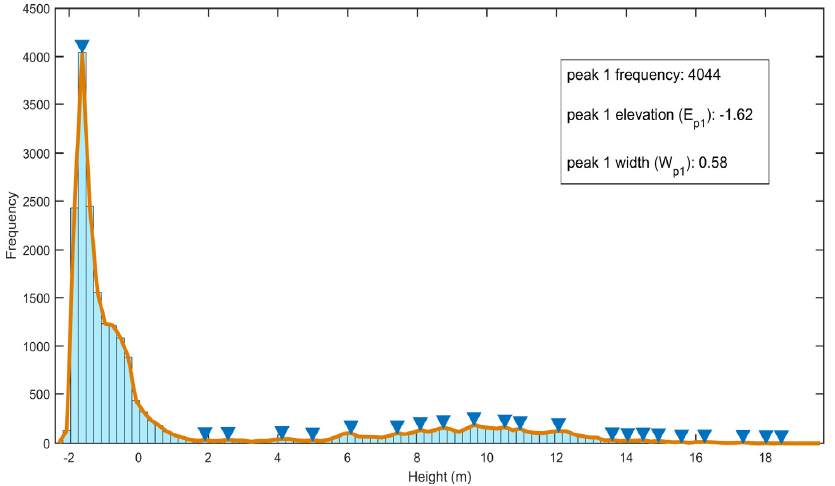
Figure 2. Histogram filtering for DTM region. Triangles represent local maximum values of histogram profile. In this example, DTM is found to be lower than 2 m in elevation, which can be estimated based on the width of first histogram peak.